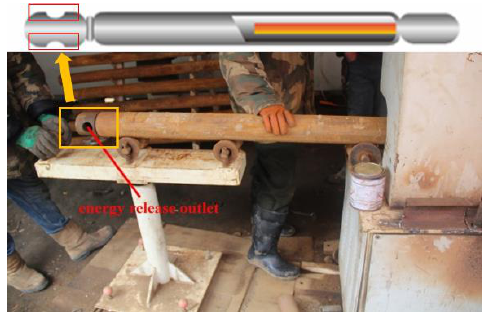
Figure 4. Type 73 carbon dioxide phase transition fracturing pipe.